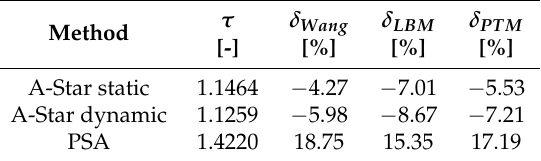
Table 2. Relative errors between the results obtained in the investigation and data from the works in